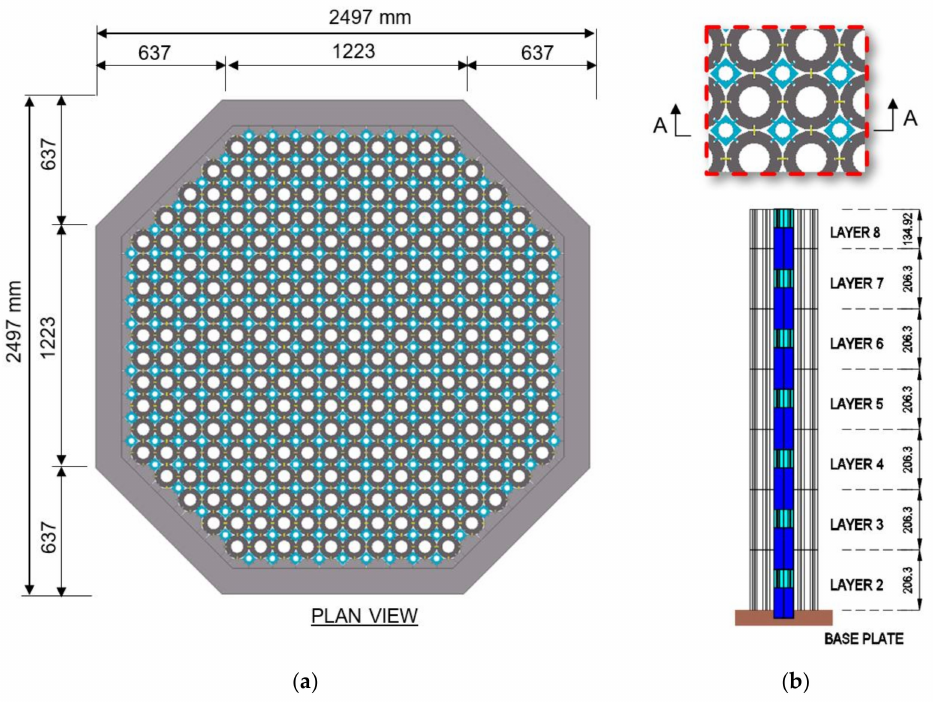
Figure 2. ( a ) MLA dimensions. ( b ) Layout of interstitial and lattice columns within the MLA.